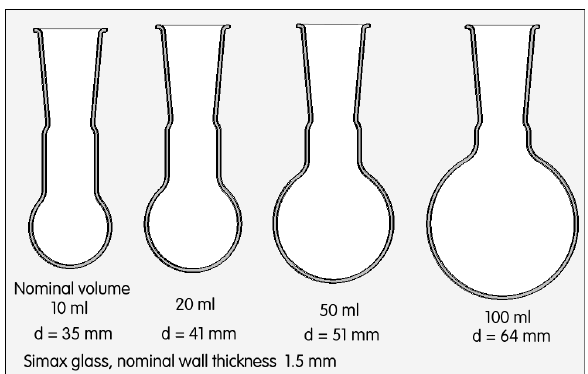
Fig. 13. Vessels obtainable from the supplier to be used in the test runs as the scaled-up shell model. The four available sizes can be usefully applied for investigation of Reynolds number effects at the same air flow velocity. The inlet necks on the top are, of course, a deviation from the ideal spherical geometry, but the downstream location is hopefully in the wake of the